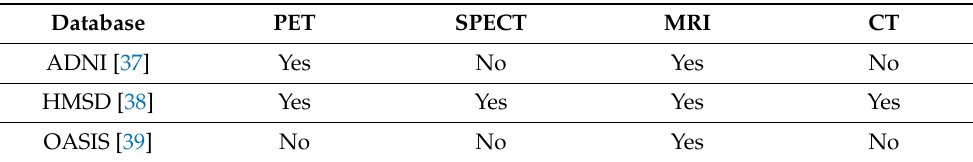
Table 2. Neuroimaging databases for Alzheimer’s